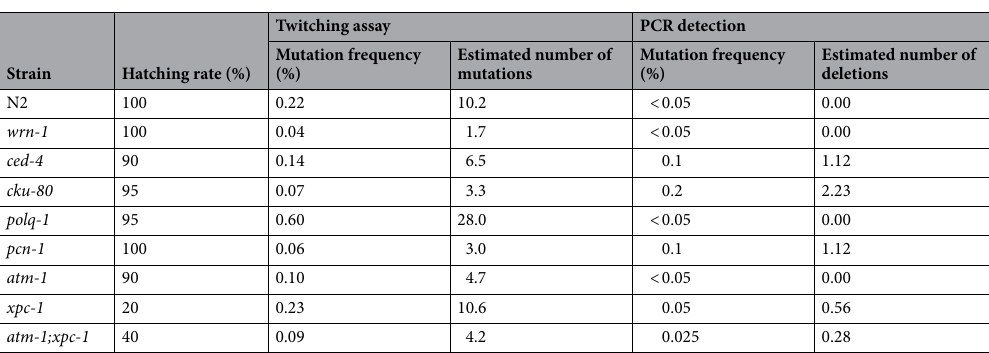
Table 1. Forward mutation frequencies and survival rates of F1 worms after the TMP/UV mutagenesis. Forward mutation frequencies were calculated by two methods, twitching assay and PCR detection. The estimated numbers of variants were calculated according to the equations described in materials and